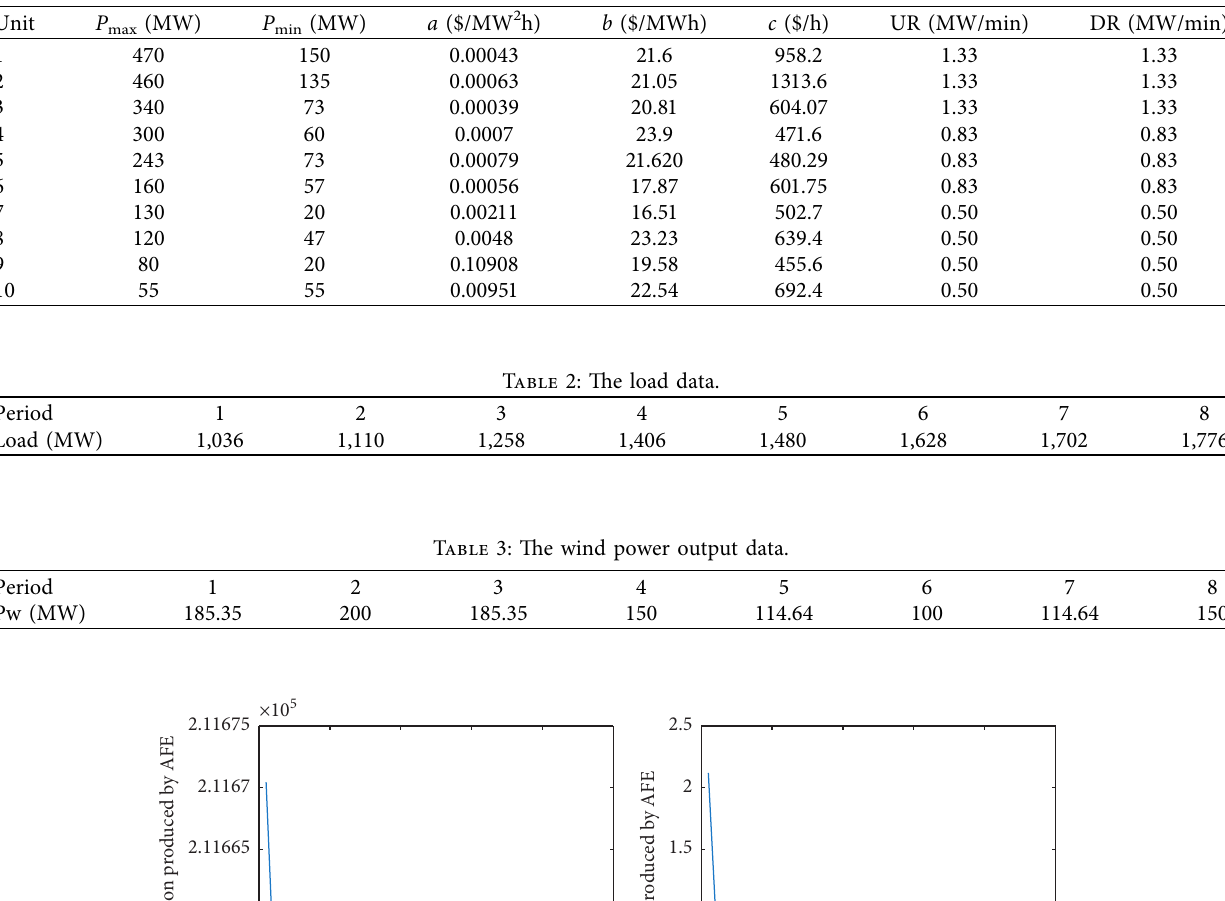
Table 1: The data for generator set.